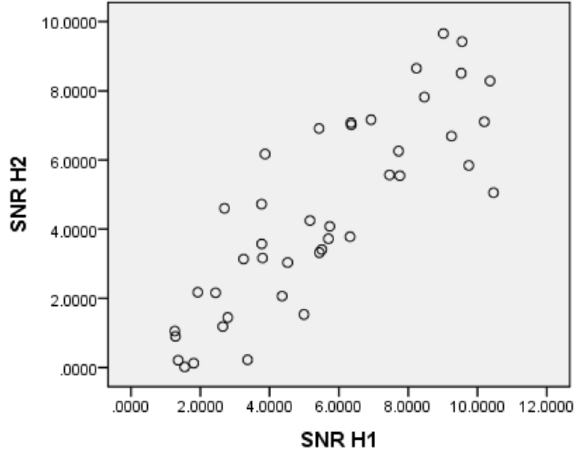
Figure 7. Scatter plot for SNR of the 1st and 2nd harmonics.